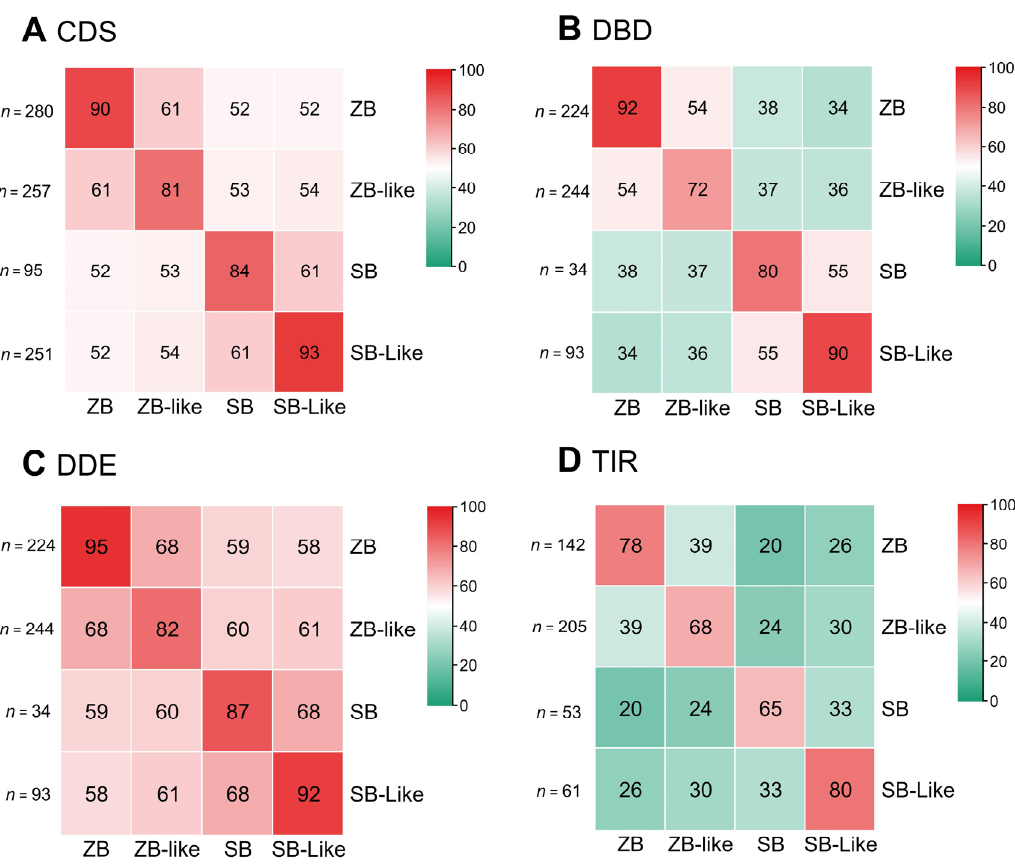
Figure 2. Sequence identities between ZB and SB elements among species. Sequence identities were measured by pairwise comparison of representative sequences of SB and ZB elements. The numbers in the heatmap are the percentage of the average values of the sequences’ identities of the two types of transposons in the corresponding row and column, and “ n ” represents the number of each type of transposon sequence ( A – D ). The average values of sequence identities were measured by pairwise comparison of representative sequences of CDS ( A ), DBD ( B ), DDE ( C ), and TIR ( D ) of ZB and SB elements.